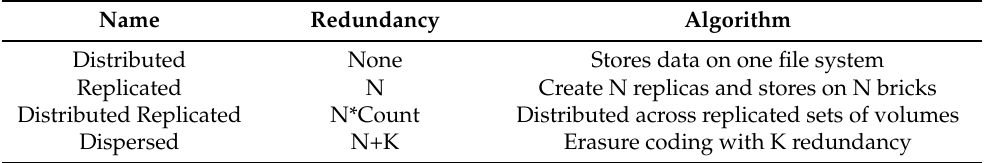
Table 2. GlusterFS